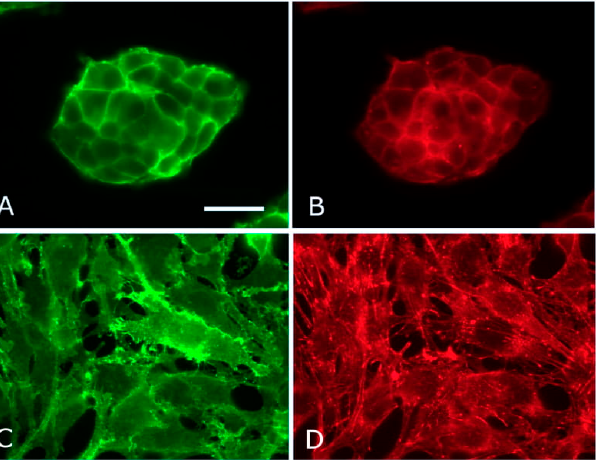
Figure 2. Epithelial–mesenchymal transformation in NMuMg cells. Control ( A , B ) and negative ( C , D ) NMuMg cells stained for β –catenin ( A , C ) and F-actin ( B , D ). Syndecan-1 was depleted syndecan-1-negative (C,D) NMuMg cells stained for β –catenin ( A,C ) and F-actin ( B , D ). Syndecan-1